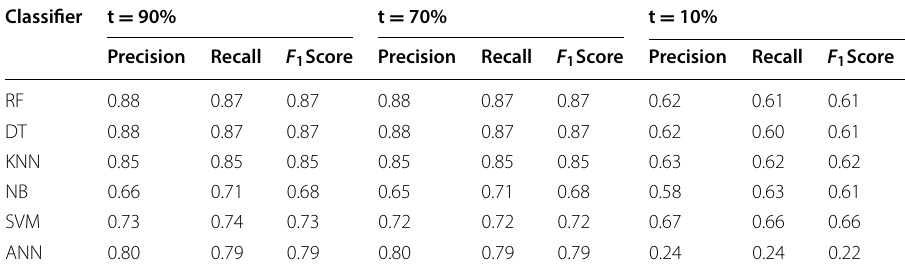
Table 8 Prediction results considering different correlation utilizing the dataset of user U2 Classifier t 90% t = =